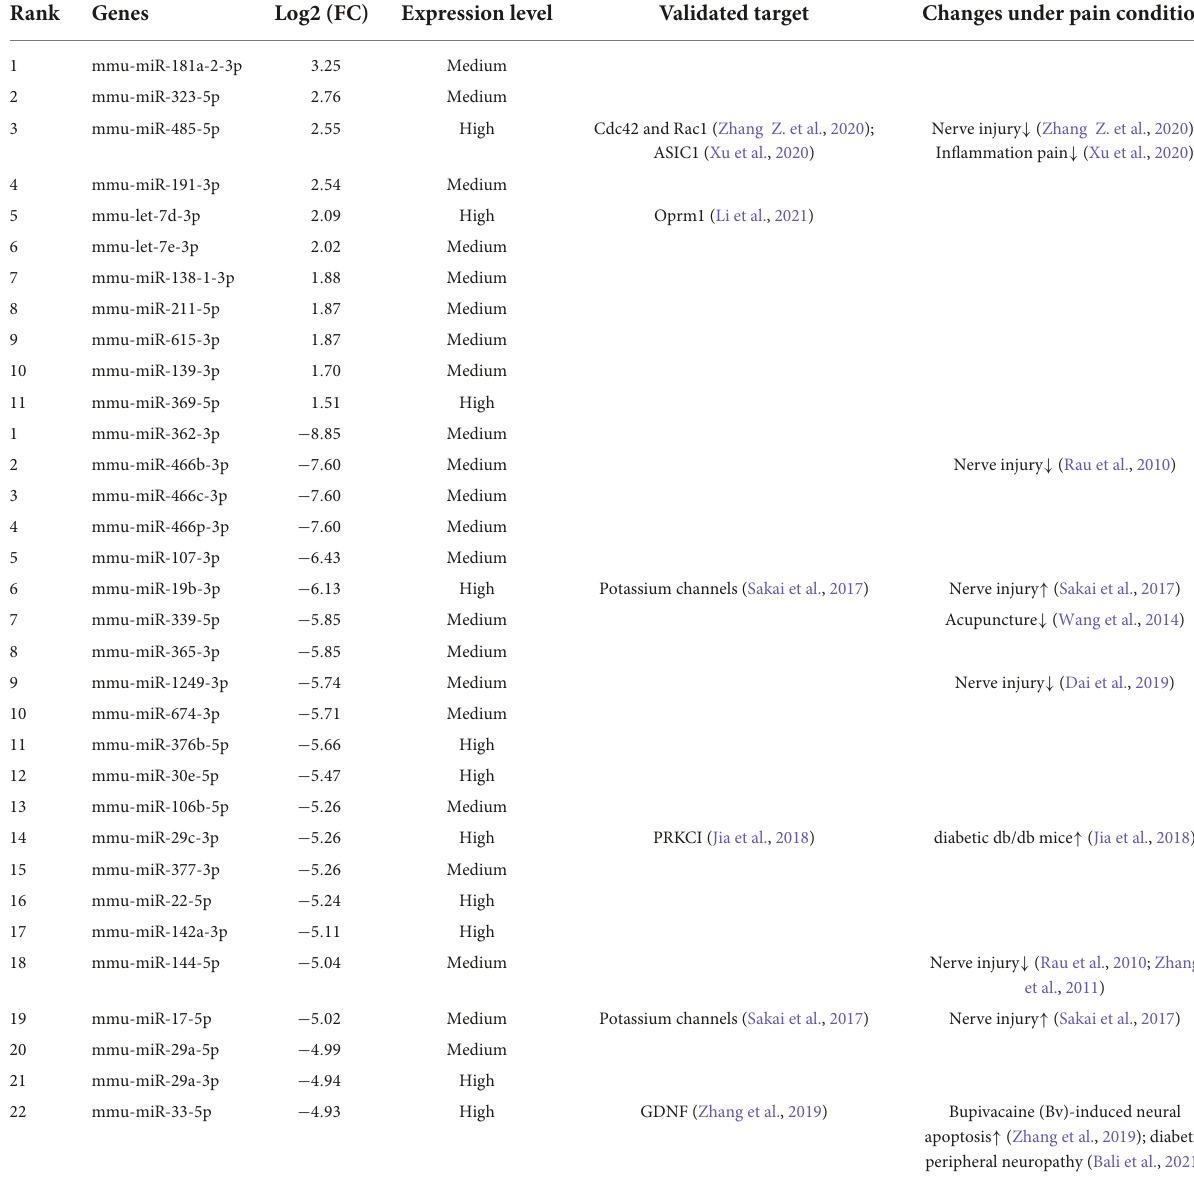
TABLE 3 The top upregulated or downregulated miRNAs induced by paclitaxel treatment. Rank Genes Log2 (FC) Expression level Validated target Changes under pain